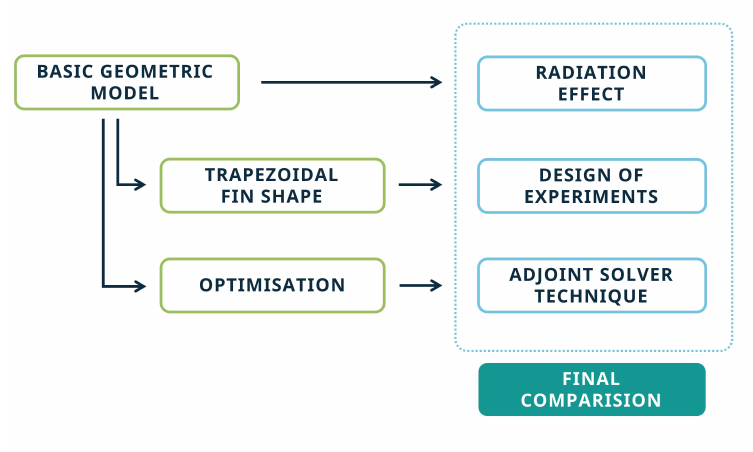
Figure 1. The flowchart of the conducted research.